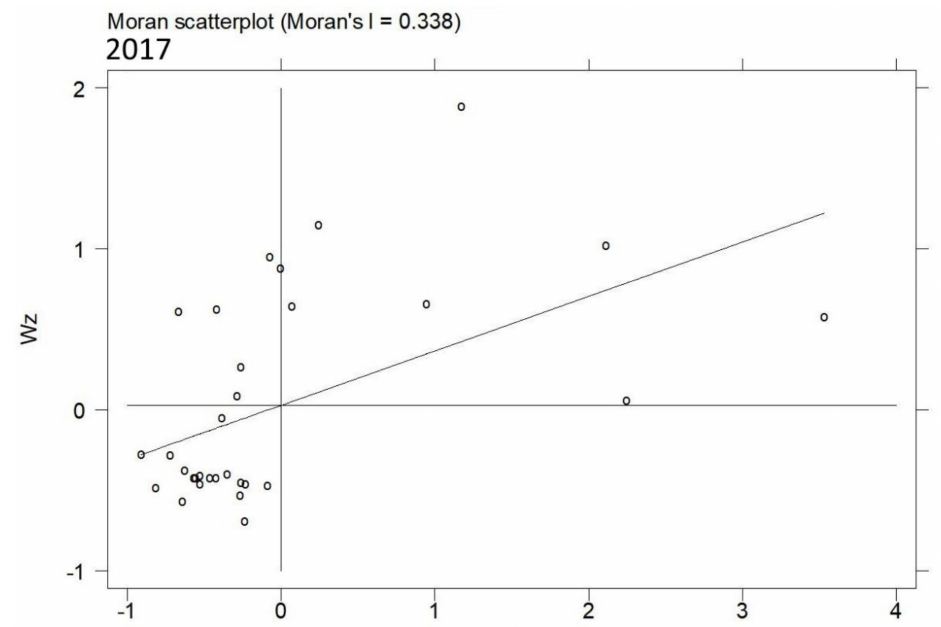
Figure 8. Moran scatterplot of the PCTLA s in the 31 Chinese provinces in